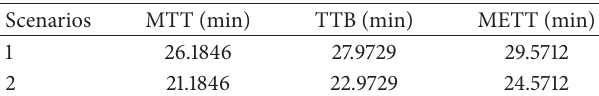
Table 1: Equilibrium travel time on route 1 for different route choice criteria.